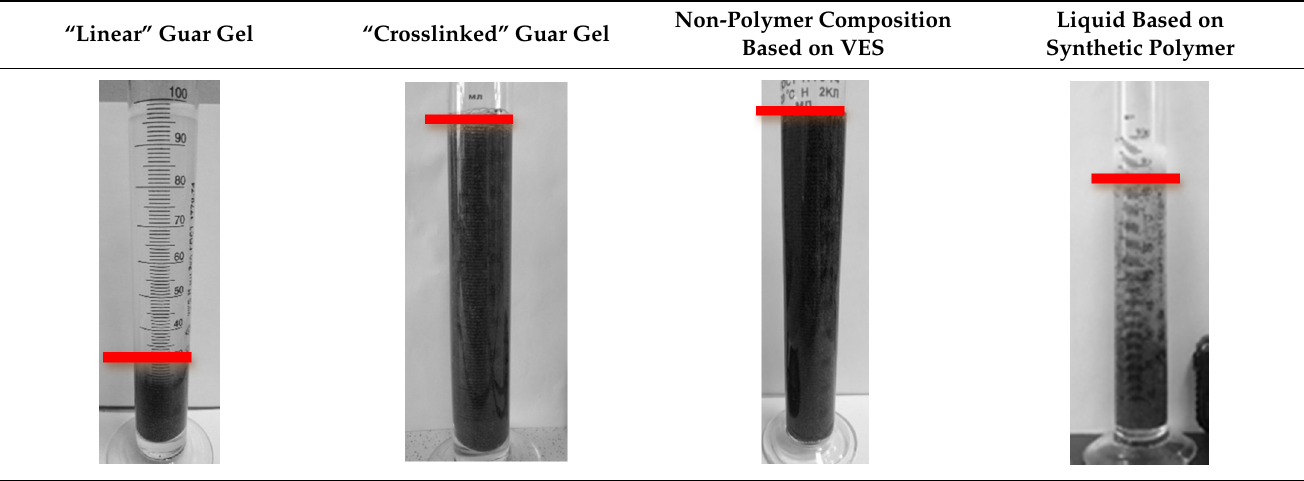
Table 2. Evaluation of the sand-carrying capacity of water-based fracturing fluids after holding under static conditions for 30 min. Proppant fraction 16/20 was used.